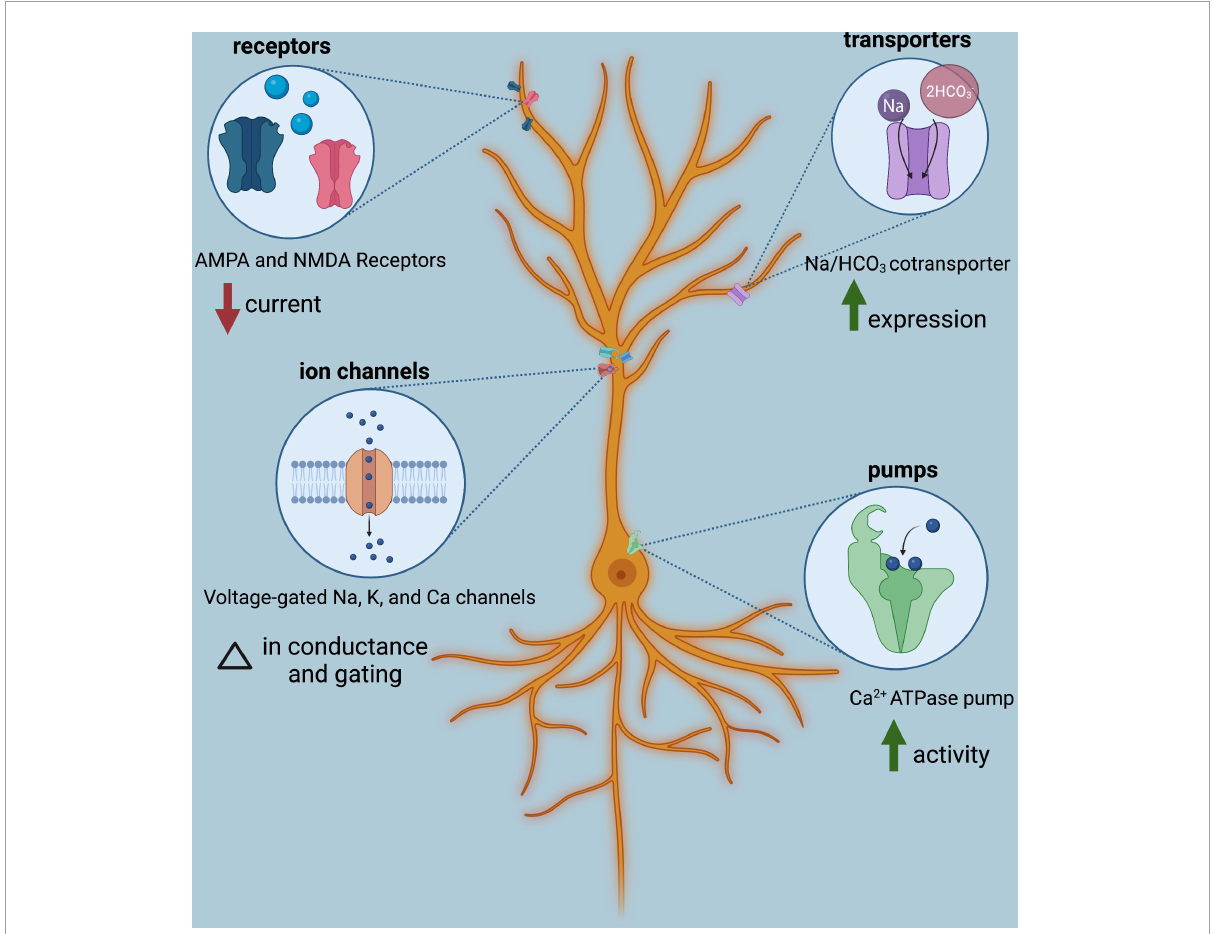
FIGURE2 Classes of membrane proteins expressed in neurons are influenced by acidic conditions modulate neural excitability. Shown is one example of each; for additional impacts of low pH on membrane protein function, see Ruffin et al. (2014). Image created with